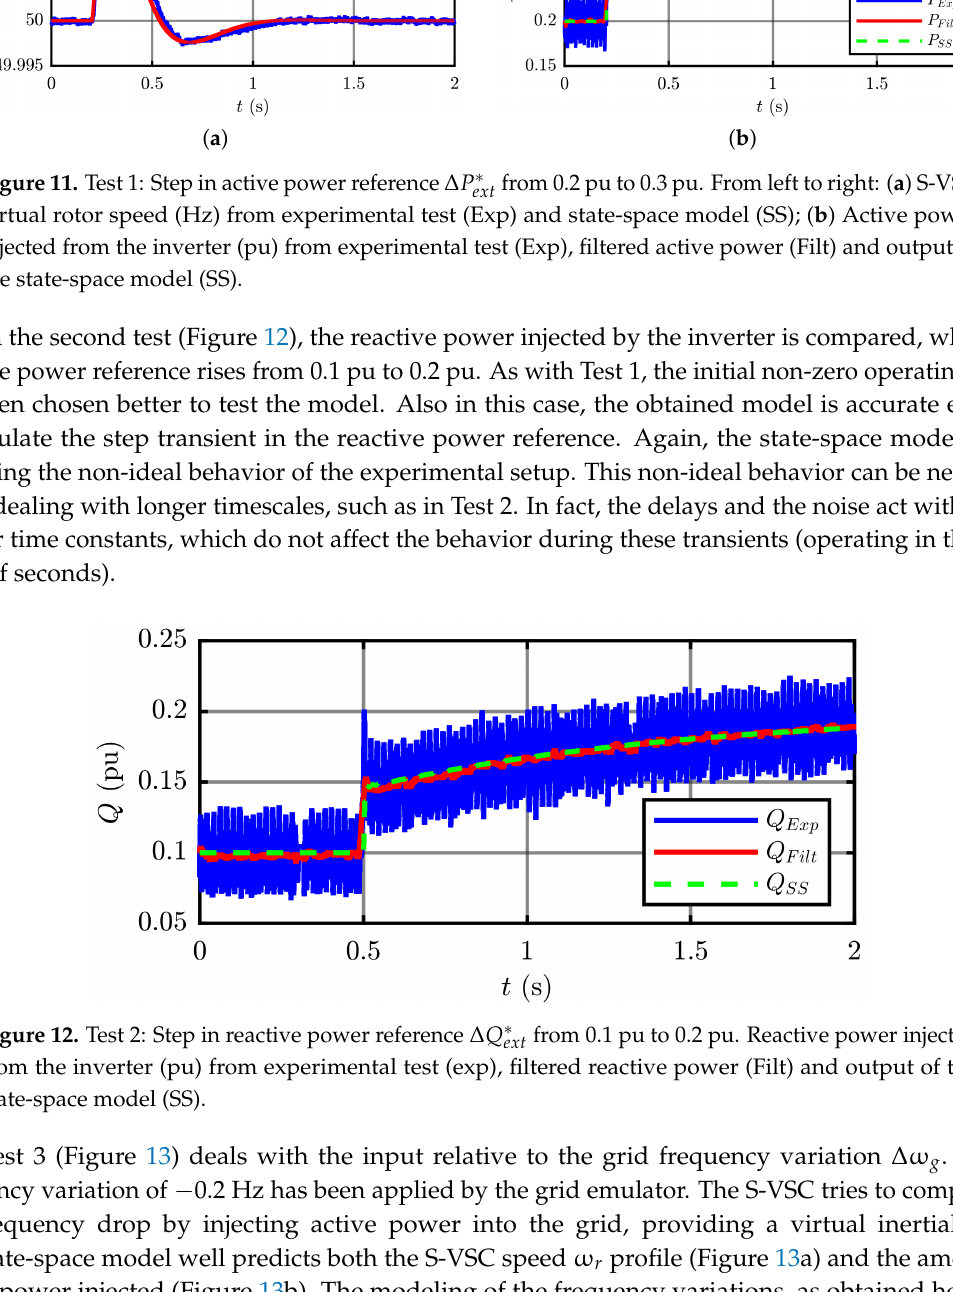
Figure 12. Test 2: Step in reactive power reference ∆ Q ∗ from the inverter (pu) from experimental test (exp), filtered reactive power (Filt) and output of the state-space model